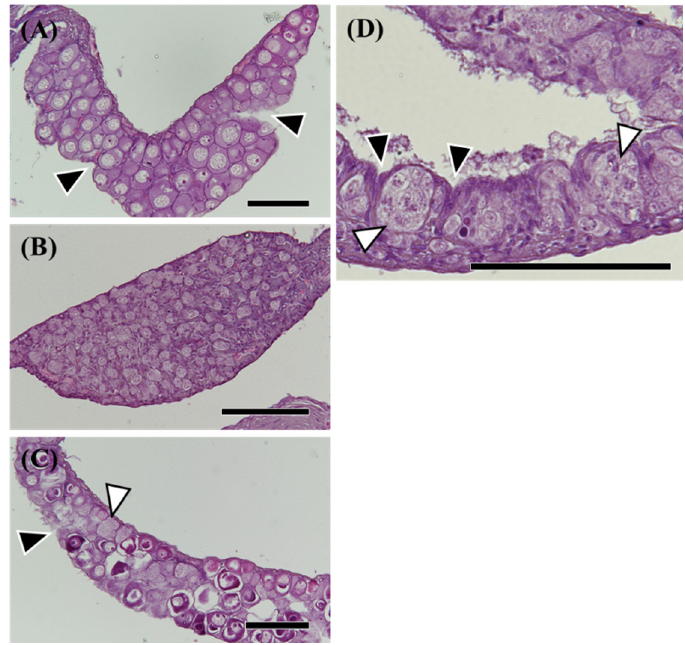
Figure 2. Hematoxylin-eosin (HE) staining of morphological sex-differentiated gonads in the wild Japanese eel Anguilla japonica. ( A , C ) Ovary. ( B ) Testis. ( D ) Differentiating ovary. Total lengths are ( A ) 342, ( B ) 306, ( C ) 257, ( D ) 297 mm. Arrowheads, notches in the epithelium of the ovary. White arrowheads, active germ cell growth. Scale bar, 100 µm.